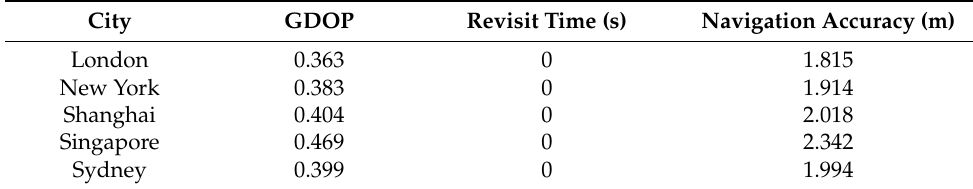
Table 3. Table of constellation coverage performance of five smart cities.